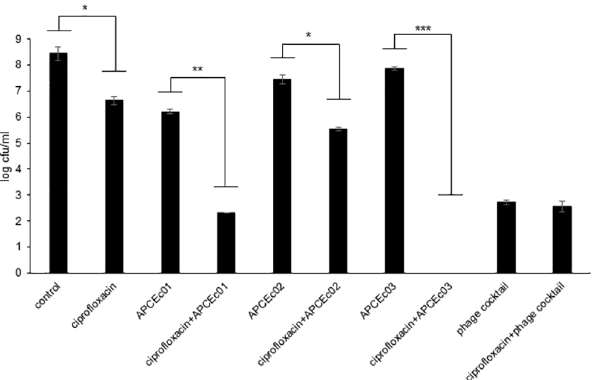
Fig 6. Effect of a combination of ciprofloxacin HCl and phages ɸ APCEc01, ɸ APCEc02, and ɸ APCEc03, alone or in cocktail, on the growth of E . coli strain DPC6051. Each condition was tested in triplicate. Bacterial counts were performed after 24 h of incubation, with a detection threshold of 20 cfu/ml. *** p < 0.001, ** p < 0.01, * p < 0.05.